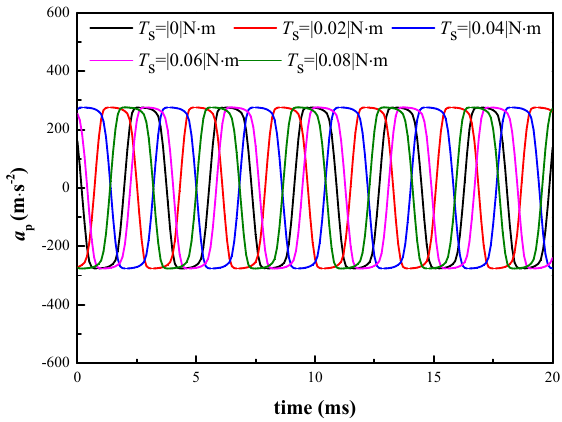
Figure 31. Accelerations of different transient flow torques.